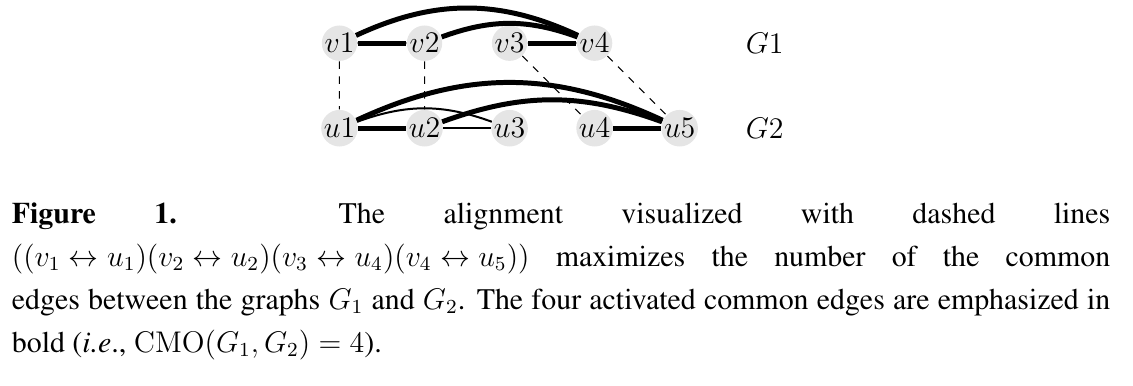
Figure 1. The alignment visualized with dashed lines (( v ↔ u )( v ↔ u )( v ↔ u )( v ↔ u )) maximizes the number of the common 1 1 2 2 3 4 4 5 edges between the graphs G and G . The four activated common edges are emphasized in 1 2 , G ) = 4 bold ( i.e ., CMO( G 1 2